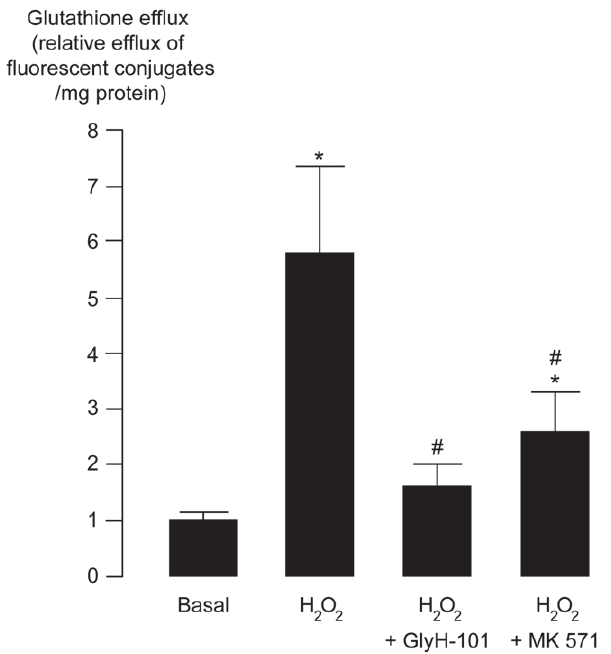
Figure 4. Effect of GlyH-101 and MK571 on H 2 O 2 -induced glutathione efflux. Erythrocytes loaded with CMFDA were incubated for 1 h with DMSO (basal), H 2 O 2 (10 mM), H 2 O 2 plus GlyH-101 (50 m M) or H 2 O 2 plus MK571 (50 m M). Efflux of the fluorescent MF-SG extruded into the extracellular media over 1-h period of treatments was computed to indicate glutathione efflux. Data were expressed as mean relative efflux of fluorescent conjugates 6 S.E. *, p , 0.05 compared with basal control; # , p , 0.05 compared with H 2 O 2 -treated group (n=3).